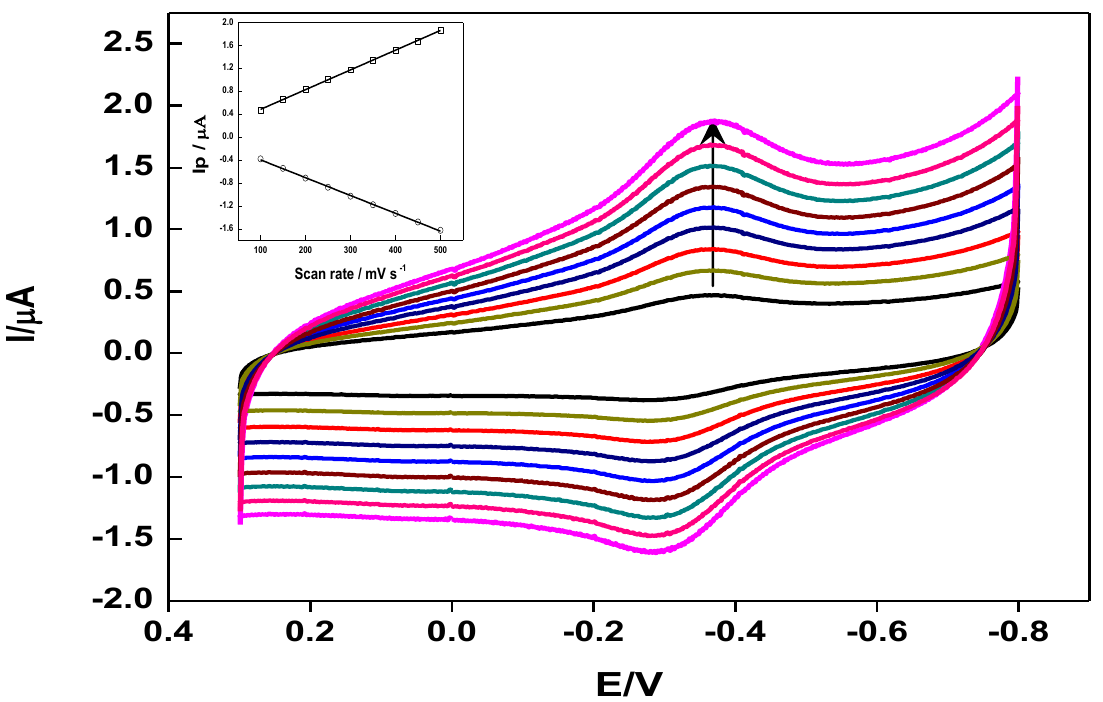
Figure 4. Cyclic voltammograms of DNA/chitosan/Fe phosphate buffer solution (pH 7.0) at different scan rates and (inset) plots of peak currents vs. scan rates. The scan rates (from inner to outer) are 100, 150, 200, 250, 300, 350, 400, 450 and 500 mV·s −1 ,